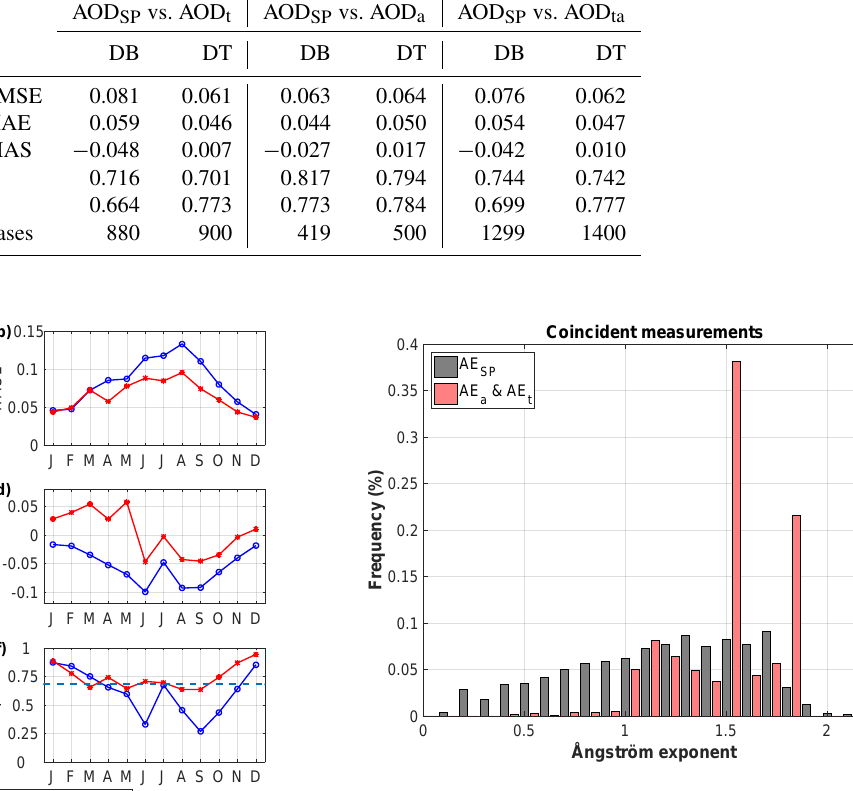
Figure 5. Frequency distribution of the Ångström exponent (AE) values from both MODIS instruments Terra and Aqua and the sun photometer are coincident in ± 30min and 25km radius around Ca-